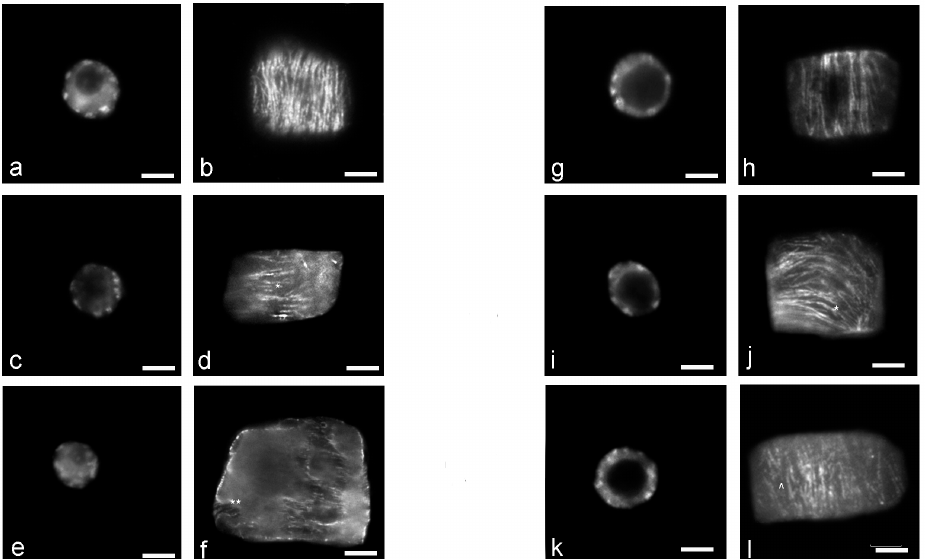
Figure 8. α -tubulin immunocytochemical detection in interphase root cells of tomato seedlings using antibodies to tubulin under control conditions, as well as under the action of NaCl at various concentrations. ( a , b ) YaLF line under 0 mM NaCl; ( c , d ) YaLF line under 75 mM NaCl; ( e , f ) YaLF line under 150 mM NaCl; ( g , h ) cv Recordsmen under 0 mM NaCl; ( i , j ) cv Recordsmen under 75 mM NaCl; ( k , l )—cv Recordsmen under 75 mM NaCl. * fragmentation of microtubules; ** disorganizations of the cortical microtubules; ^ thinning of microtubules. Scale is 5 μ m.